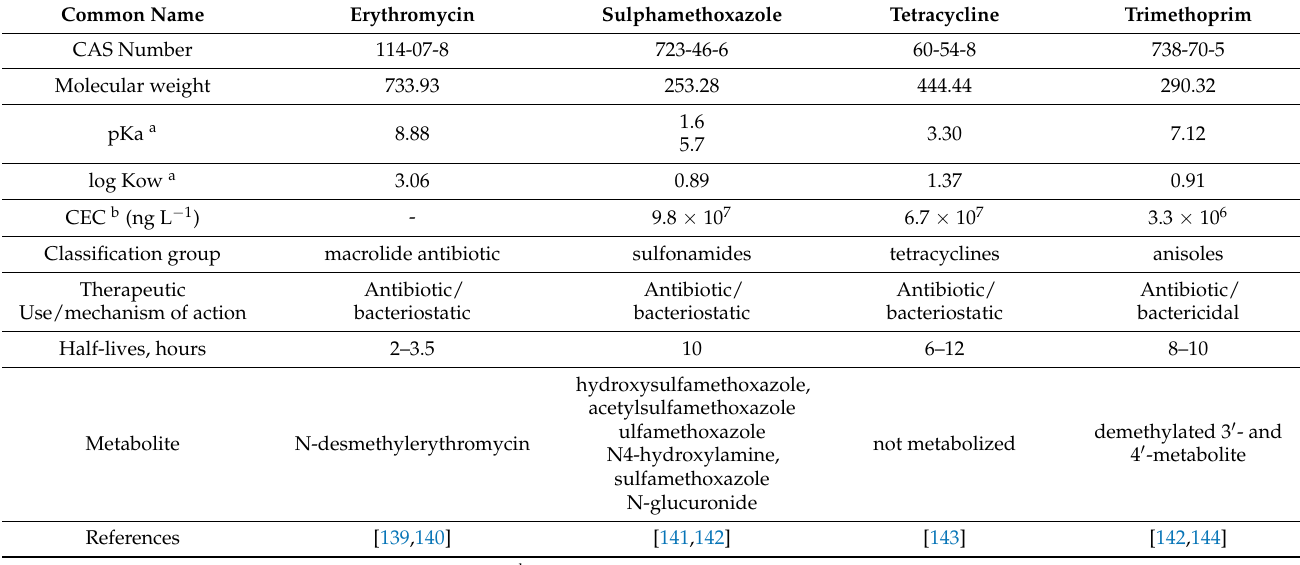
Table 4. Characteristics of the discussed